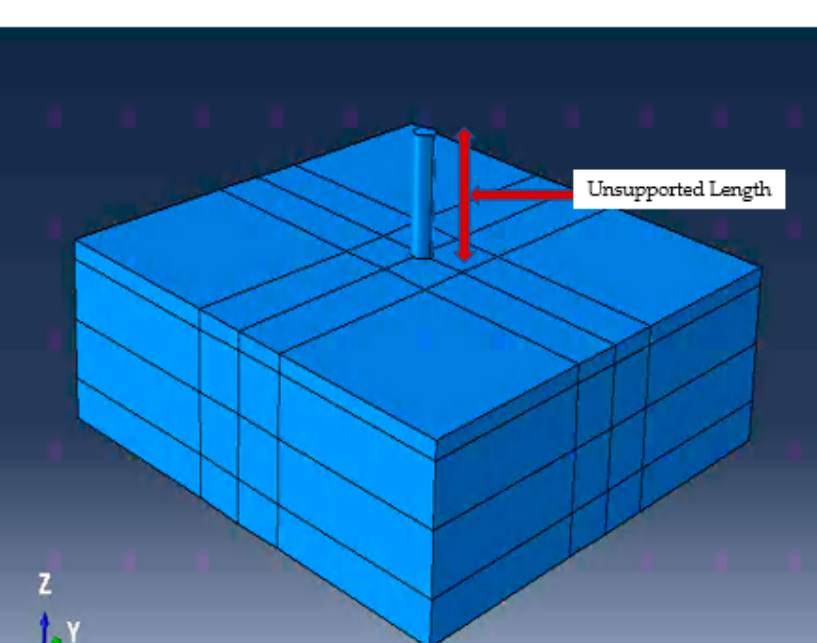
Figure 8. Isometric view of the FEM without topsoil layer(fill).